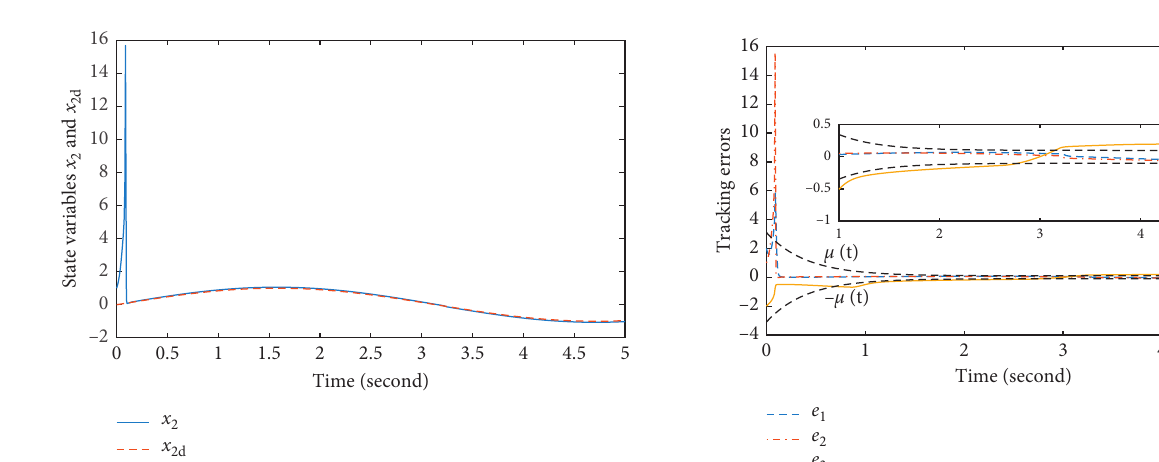
and x with control scheme (33). 1 1 d